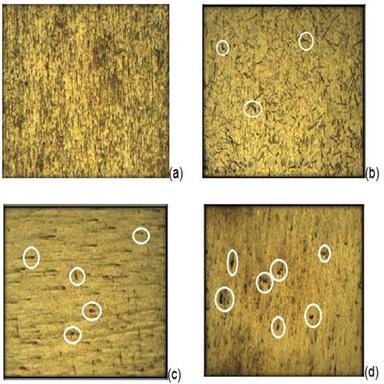
Microstructral Image of the Al-4032 matrix composite at 100X magnification for different compositions (a) A0 (b) A1 (c) A2 (d) A3